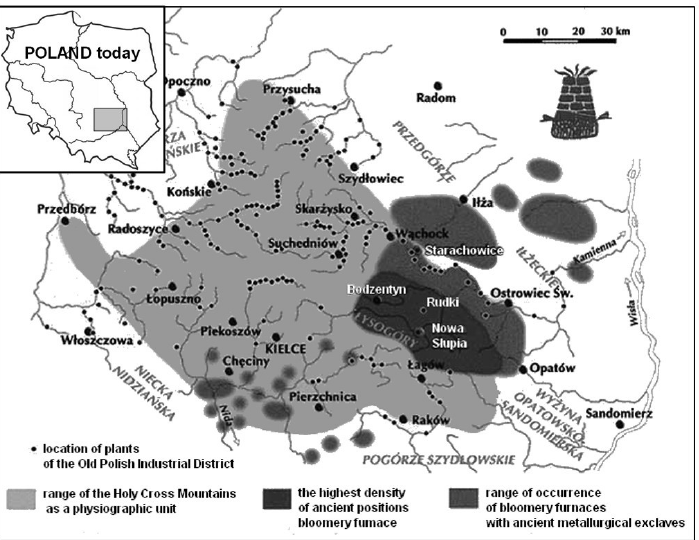
Figure 2. Range of the ancient ´Swi˛etokrzyskie ironworking. Reproduced with permission from Orze- chowski S., Suliga I. (eds.), 50 years of research on ancient ´Swi˛etokrzyskie ironworking. Archeology— Metallurgy—Education (K. Bielenin, Przychodni A.—´Swi˛etokrzyskie ironworking in school educa- tion); published by KTN Kielce, 2006